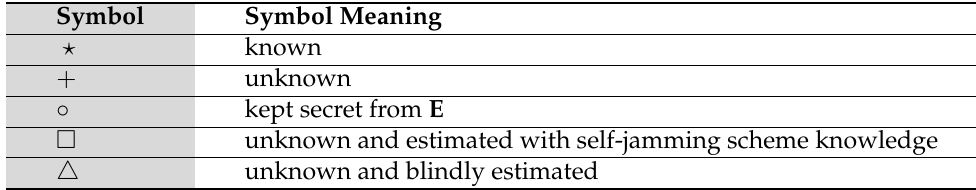
Table 3. Symbols meaning of symbols used in Table